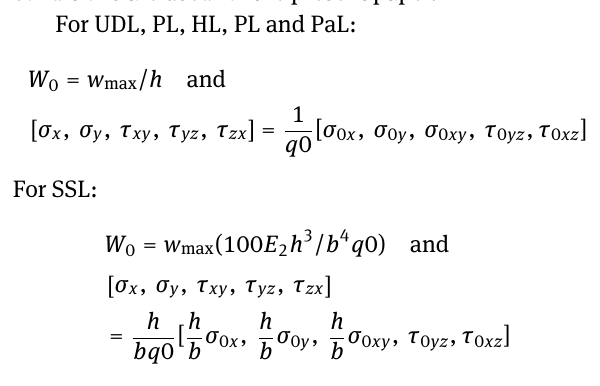
Table 1: Convergence study for transverse central deflection in bending of laminated composite sandwich